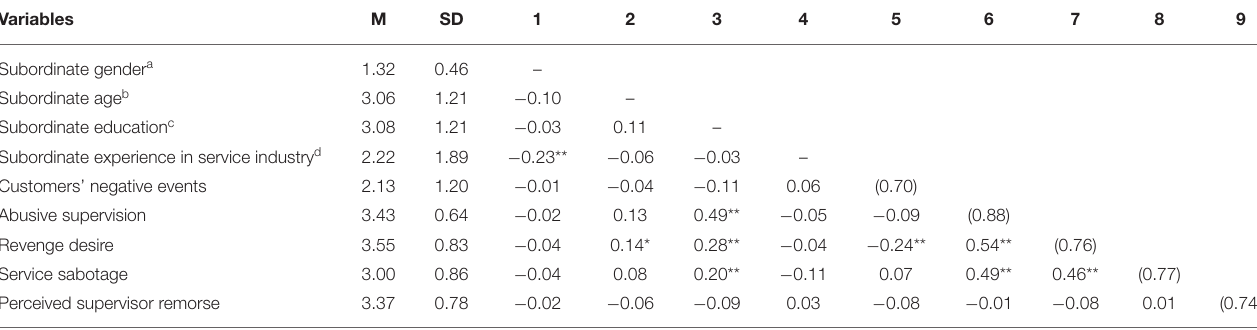
TABLE 1 | Intercorrelations, descriptive statistics, and estimated reliabilities among the latent